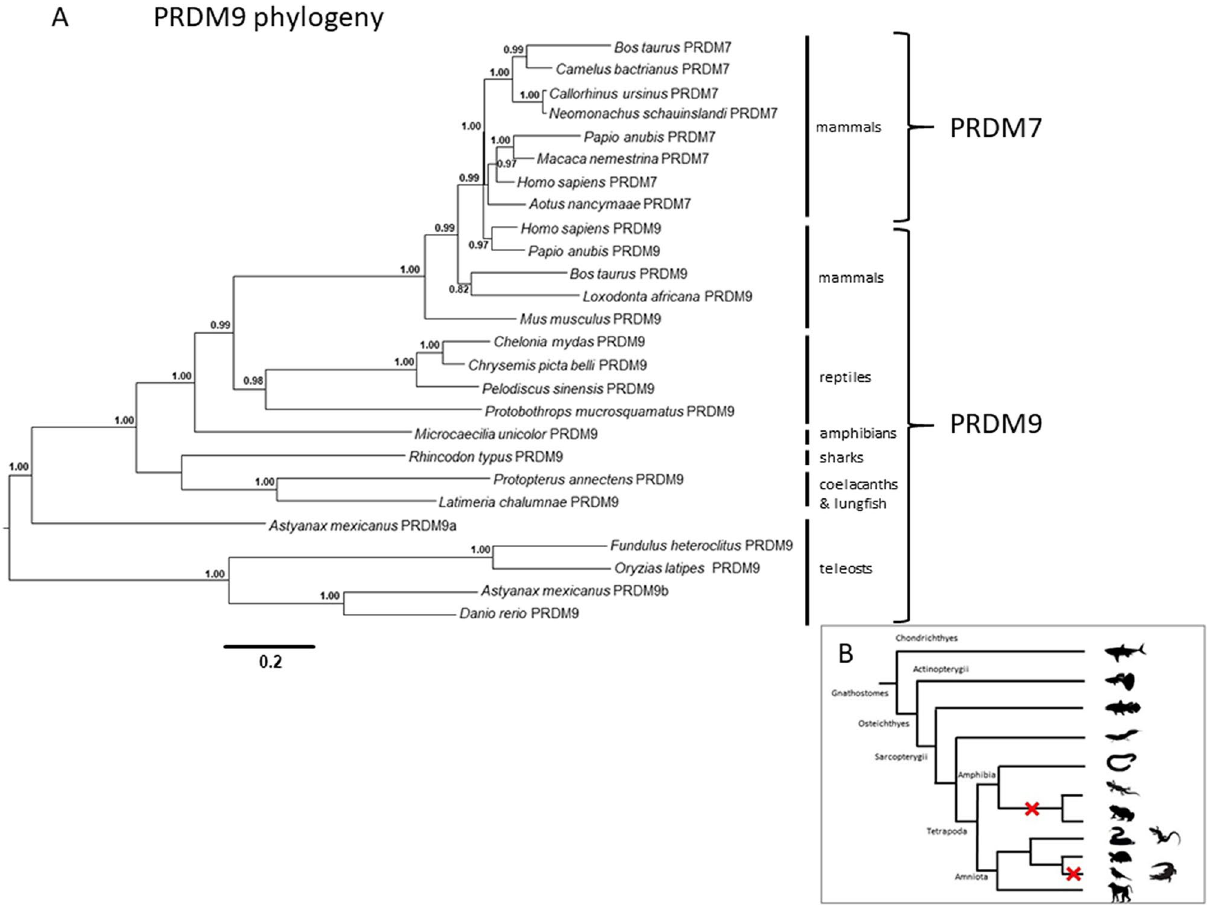
Figure 5. PRDM9 phylogeny. (A) Phylogenetic analysis of PRDM9 performed through Bayesian inference. The two curly brackets group PRDM7 and PRDM9 sequences. Vertical bars indicate to which animal group the sequences analysed belong to. (B) Schematic representation of PRDM9 evolutionary history in gnathostomes. Red cross indicates gene